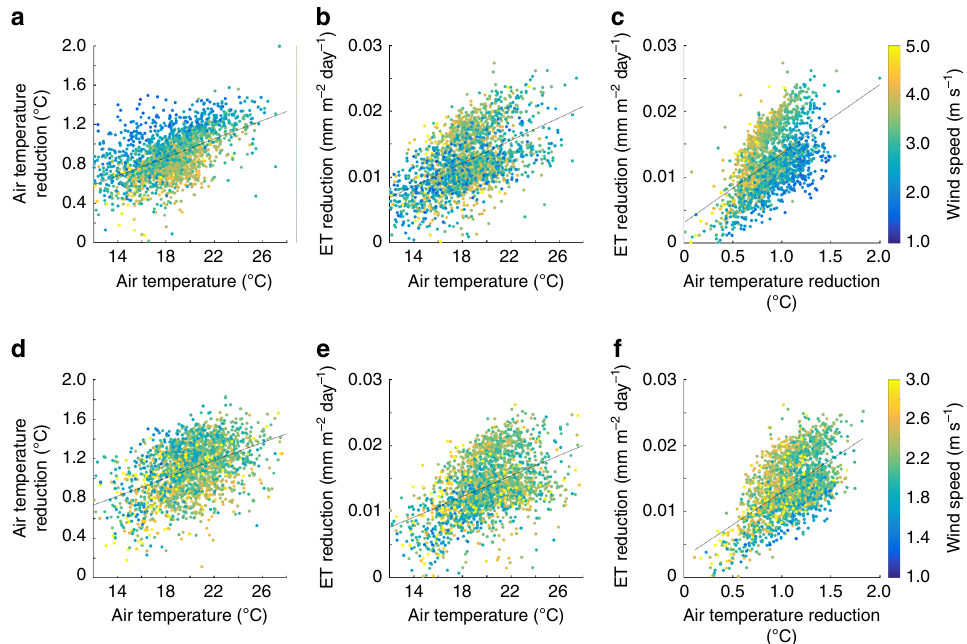
Fig. 7 Correspondence between absolute air temperature and cool-roof-induced reduction in air temperature and evapotranspiration. Circles represent simulated daily means of air temperature reduction versus air temperature ( a , d ), evapotranspiration (ET) reduction versus air temperature ( b , e ), and ET reduction versus air temperature reduction ( c , f ) for June – October of 2001 – 2015, averaged over urban surfaces in NorCal ( a , b , c ) and SoCal ( d , e , f ). The circle colors along with the color bars illustrate the daily wind speeds. The black lines show the best linear fi t (in a least-squares sense) to